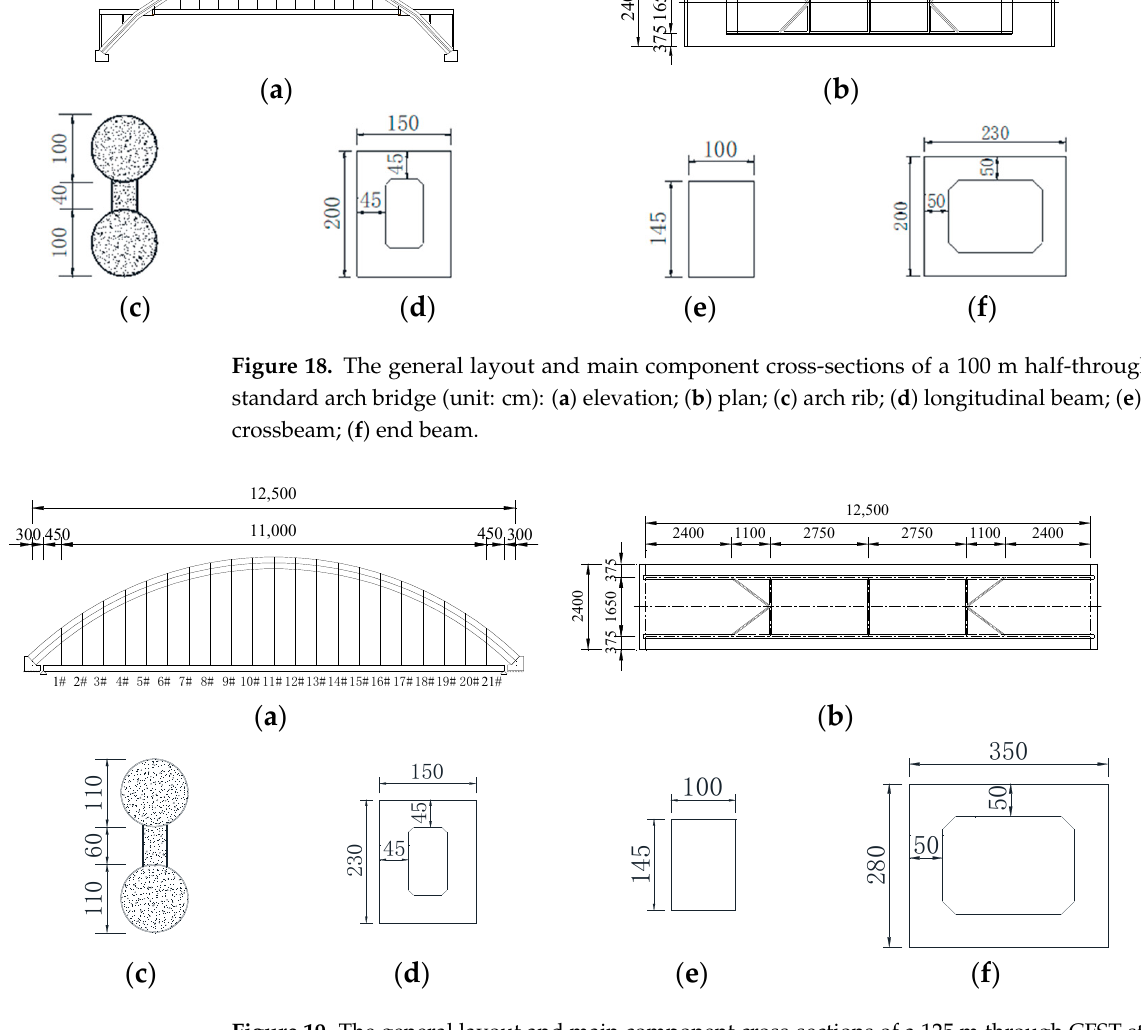
Figure 19. The general layout and main component cross ‐ sections of a 125 m through CFST standard arch bridge (unit: cm): ( a ) elevation; ( b ) plan; ( c ) arch rib; ( d ) longitudinal beam; ( e ) central crossbeam; ( f ) end beam.